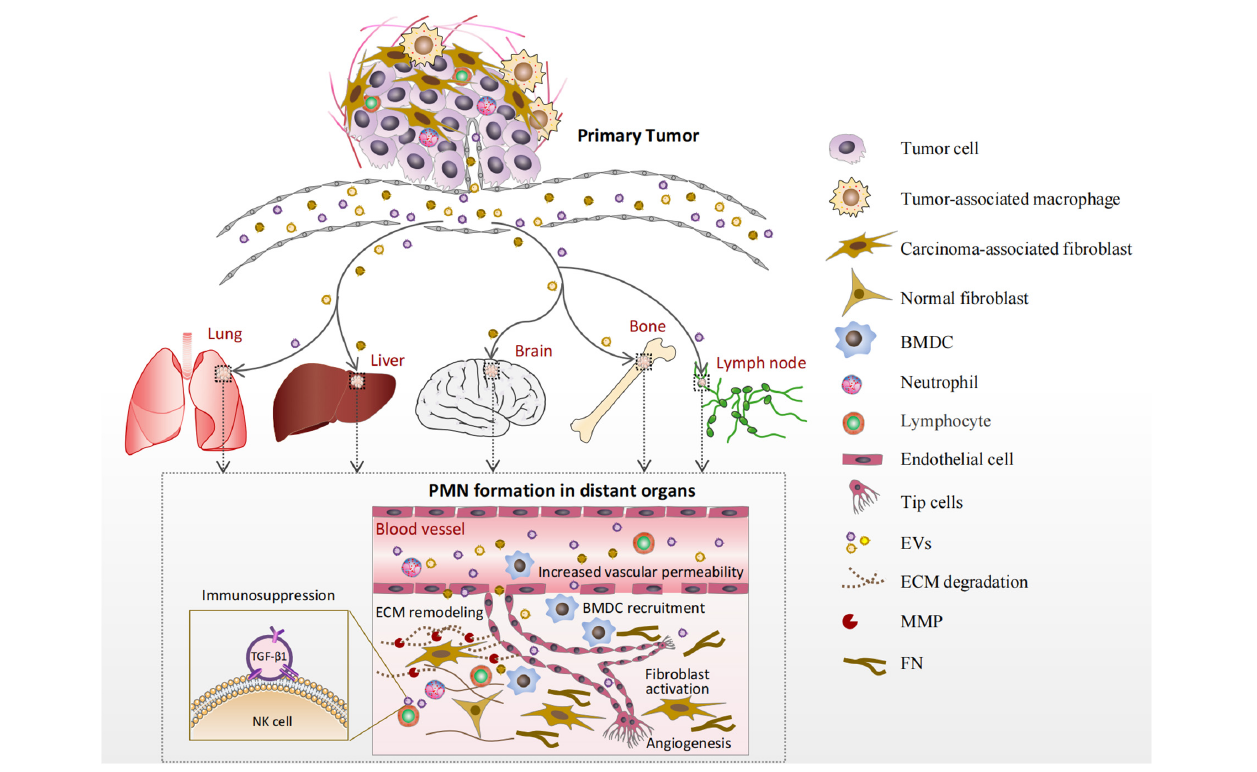
FIGURE 1 | Formation of the pre-metastatic niche (PMN) in various organs. Extracellular vesicles (EVs) produced by tumor and stromal cells enter the circulation and arrive at distant organs such as the lung, liver, brain, bone marrow, and lymph nodes (LNs). Increased vascular permeability is an early event in PMN formation. Then, EVs cause extracellular matrix (ECM) remodeling principally by activating resident normal fibroblasts. The activated fibroblasts deposit new ECM components, such as FN, and produce matrix metalloproteinases (MMPs). Bone marrow-derived cells (BMDCs) are recruited into the target organs by EVs and involved in angiogenesis and/or immune responses. Furthermore, EVs can deliver their cargos to endothelial cells or immunocytes directly in the PMN to promote angiogenesis or create an immunosuppressive microenvironment.